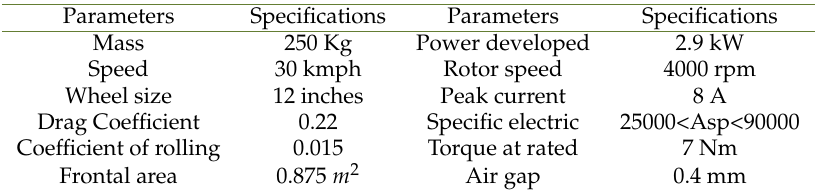
Table 1. Electric vehicle specification and SRM model.